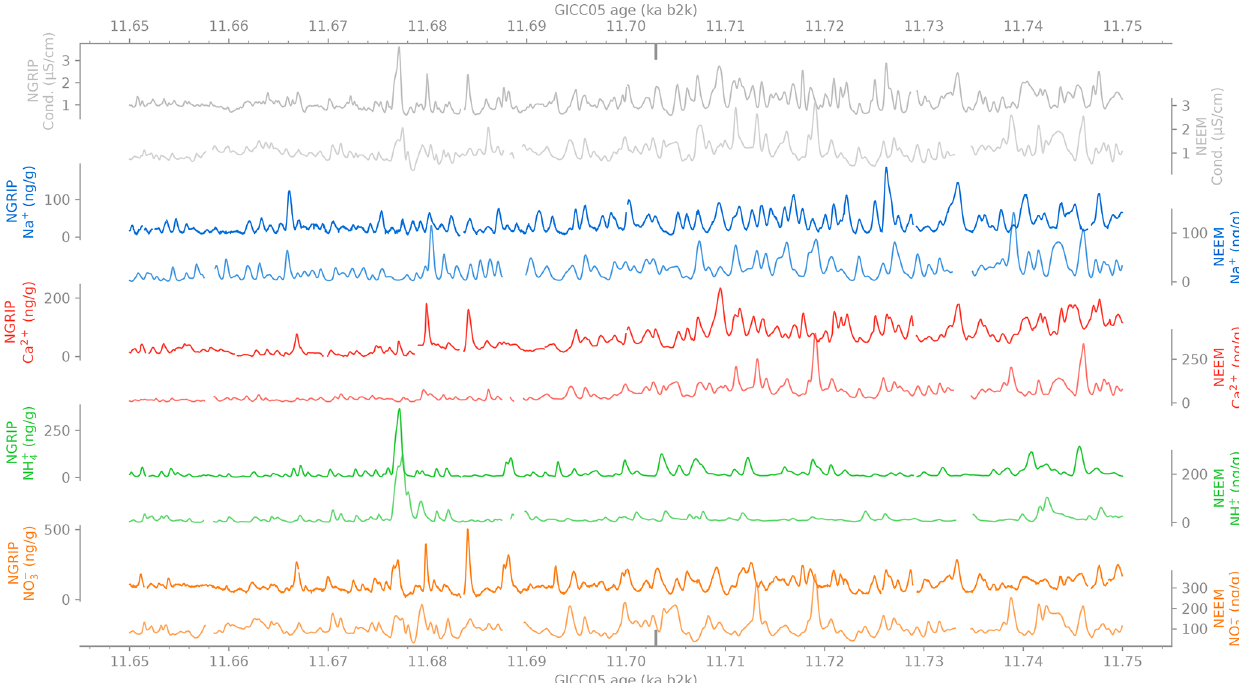
Figure 4. Full 1mm resolution data sets from both cores over the transition from the Younger Dryas cold period to the Preboreal Holocene as marked by the two vertical markers at 11703kyrb2k (Rasmussen et al., 2014). Data from the NGRIP core is shown in darker shading with axis on the left-hand side, data from the NEEM core in pale colors with scales on the right-hand side. The annual cycles, especially visible in the calcium and sodium records, indicate the rapid increase of annual snowfall over the transition, going hand in hand with large concentration changes. Especially noteworthy is the clear NH + -spike visible in both ice cores, likely a signal from a North American wildfire. 4